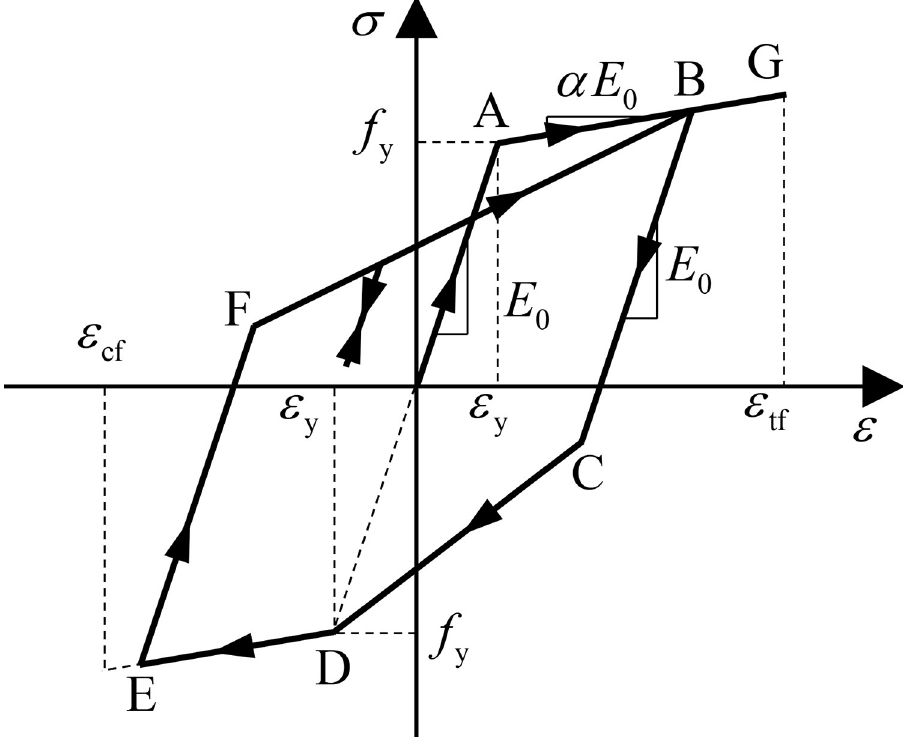
Fig 4. Uniaxial constitutive model for